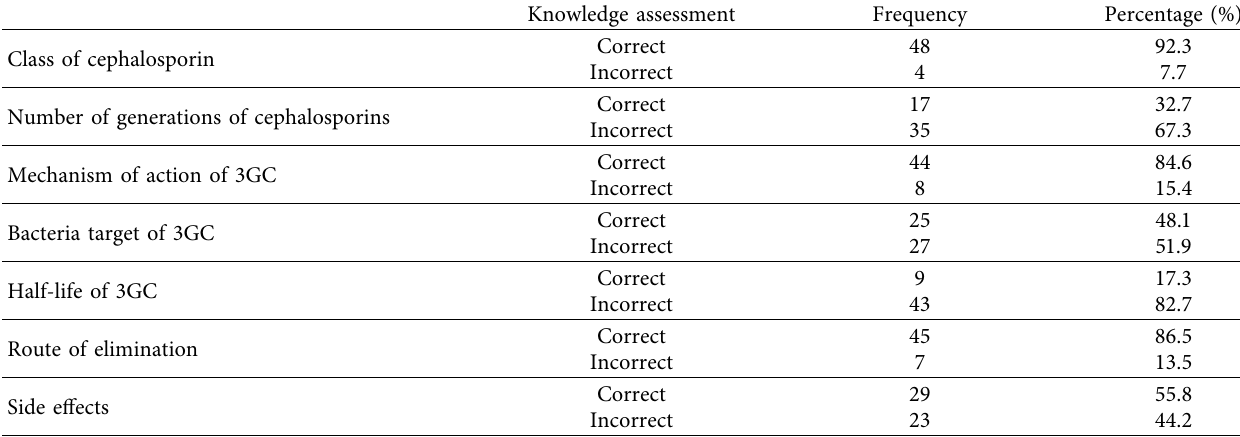
Table 1: Assessment of the knowledge of medical doctors on cephalosporins and 3GC.